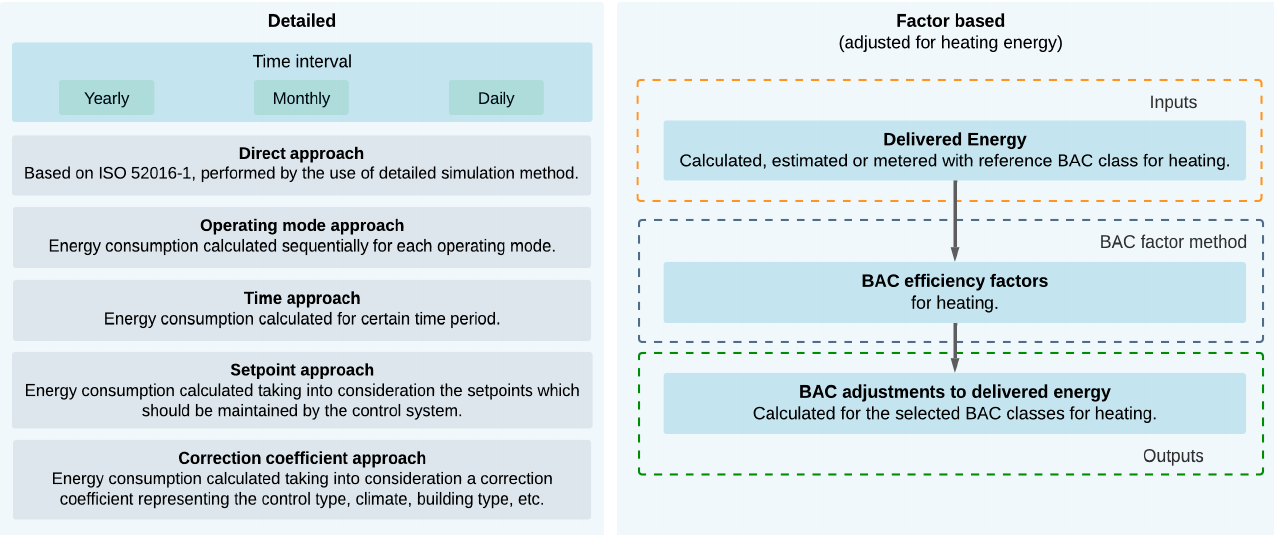
Figure 2. Calculation methods for BACS influence on system energy efficiency. Adapted from ISO 52120 ‐ 1:2022 [8].